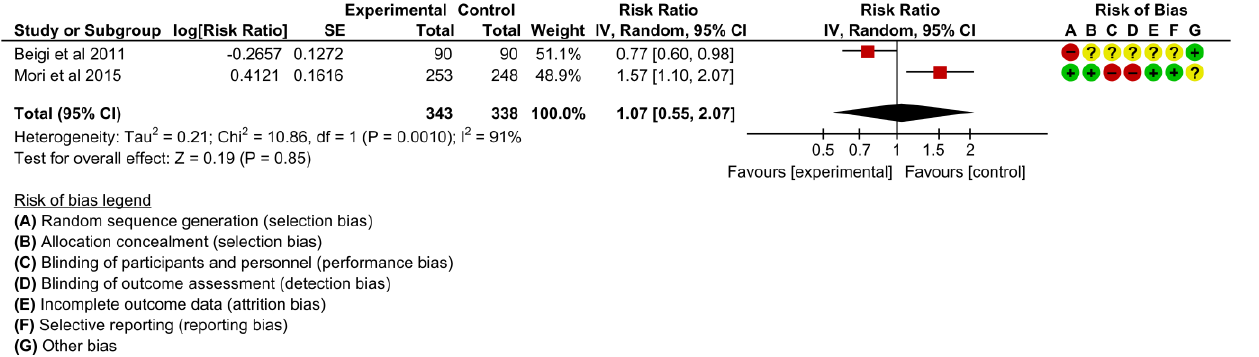
Figure 6. Meta-analysis for the effect of MCH handbook interventions vs. standard care on cesarean delivery [19,21]. Red color with a − symbol means a high risk of bias, yellow color with a ? symbol means an unclear risk of bias, and green color with a + symbol means a low risk of